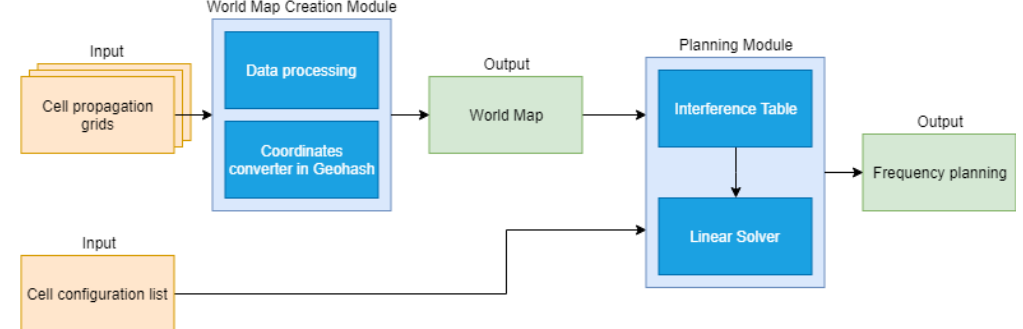
Figure 10. Flowchart representing the algorithm